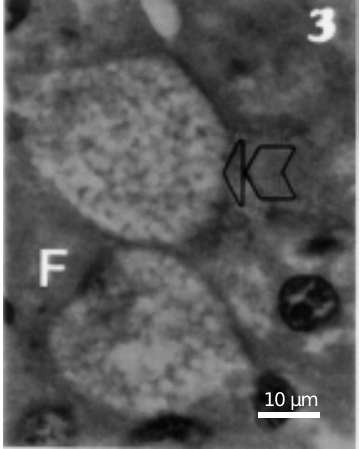
Figure 3 - Fasciculata region (F) of a vis- cacha captured in March (summer). The cytoplasm of these cells is completely vacuolated (arrow). H-E; 1000X.